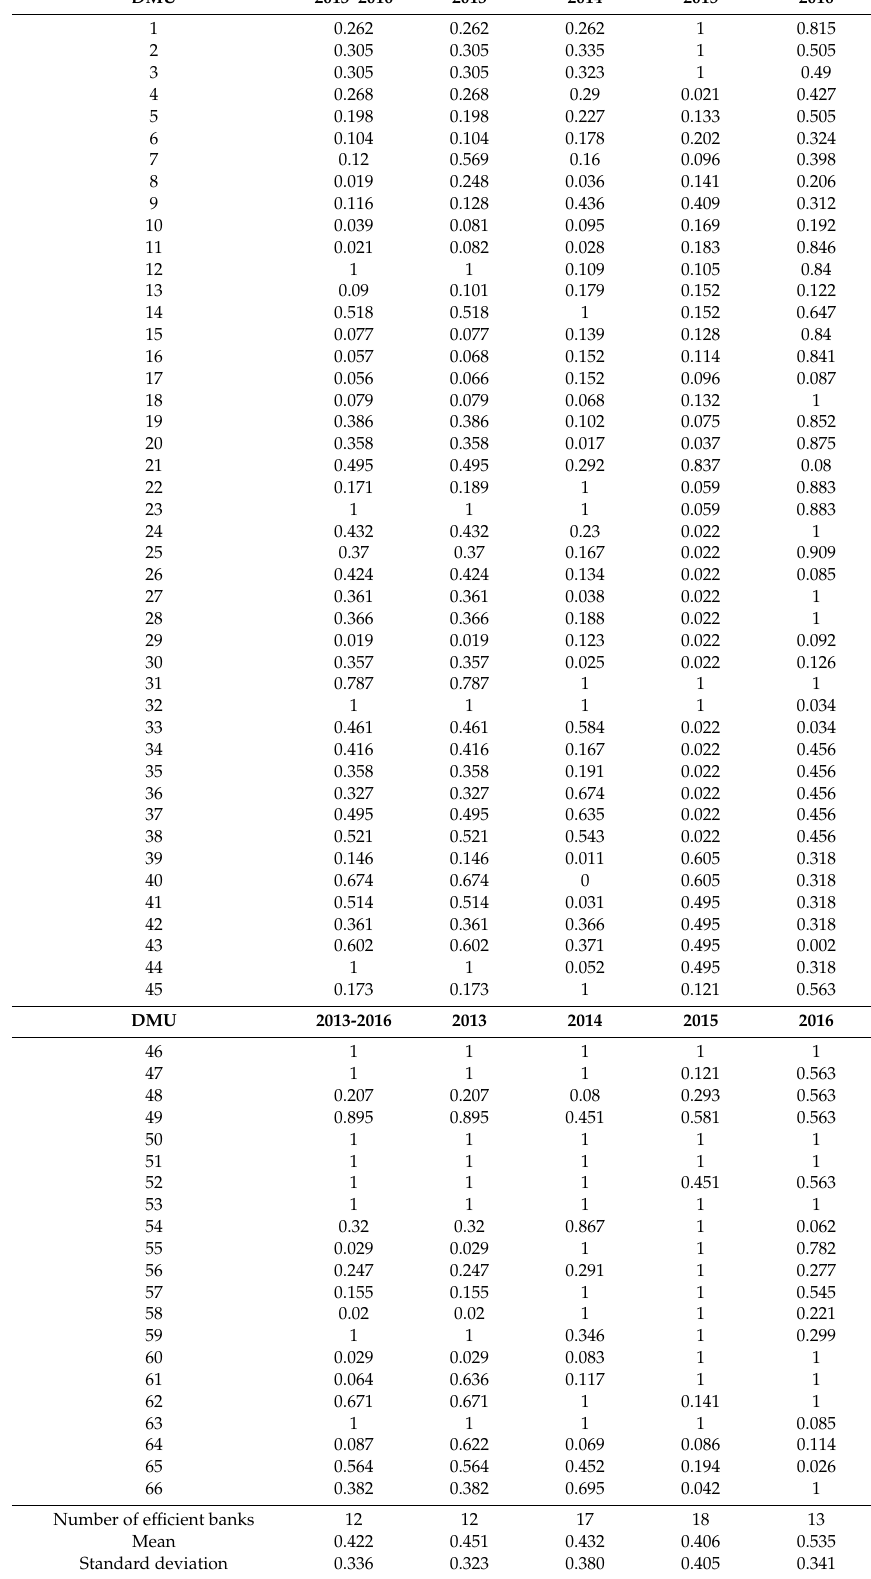
Table 3. E ffi ciency